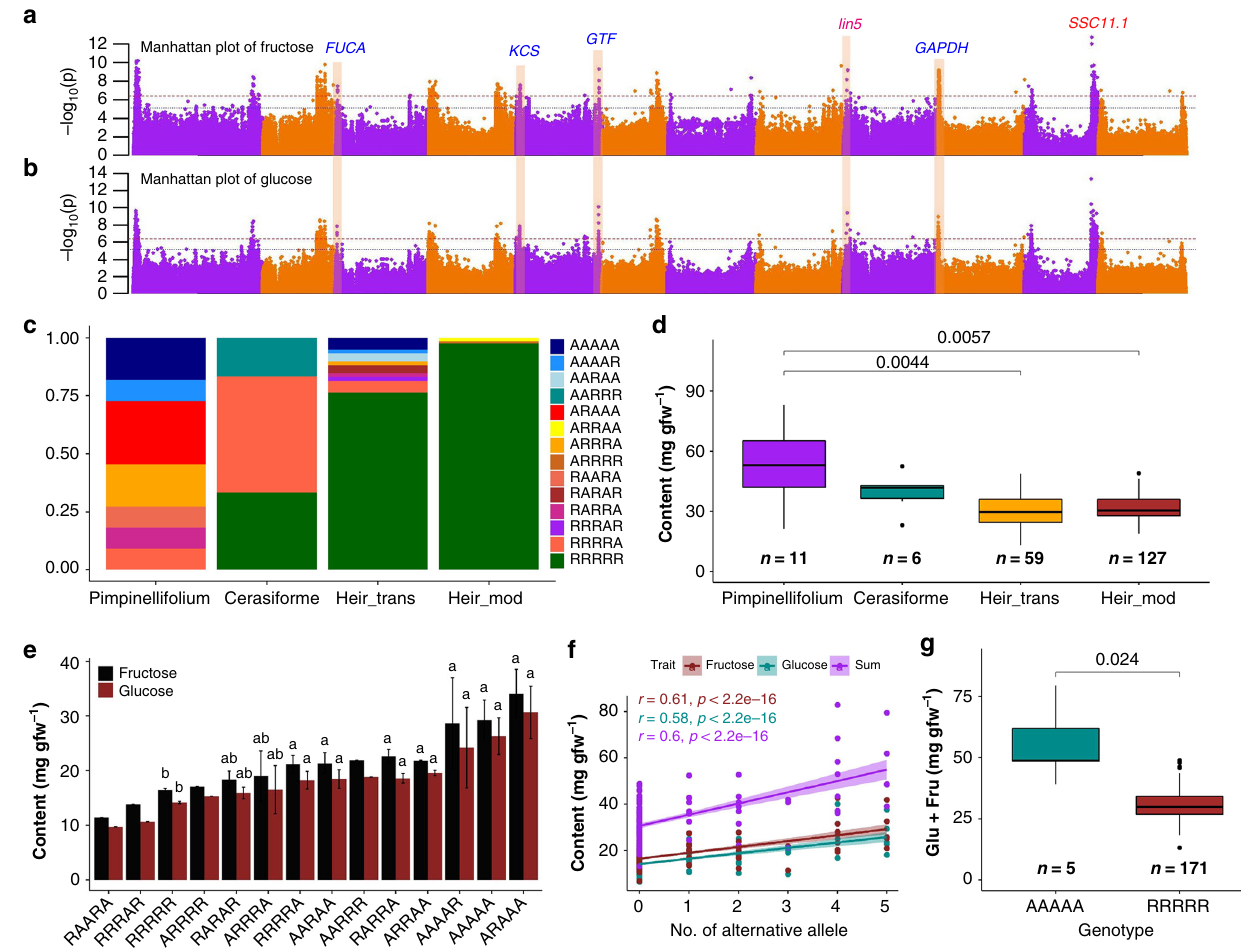
Fig. 2 Combinations of fructose and glucose alleles for the improvement of tomato sugar content. Only alleles that were signi fi cantly associated both with fructose and glucose were analyzed. a , b Manhattan plot for meta-analysis of genome-wide association analysis of fructose ( a ) and glucose ( b ) content. Candidates and previously identi fi ed genes were labeled in blue and red, respectively. FUCA, alpha-L-fucosidase 1 ; KCS, fatty acid elongase 3-ketoacyl-CoA synthase ; GTF, glucosyltransferase ; GADPH, glyceraldehyde-3-phosphate dehydrogenase . c Allele distribution of fructose/glucose content at positions: chr3:1,506,106, chr5:3,403,706, chr5:63,485,334, chr9:3,477,979, and chr10:422,707 that were both signi fi cantly associated with fructose and glucose in S. lycopersicum var cerasiforme (cerasiforme), heirloom + transitional (heir_trans), heir + modern (heir_mod), and the closest wild species S. pimpinellifolium (pimpinellifolium) tomato accessions (see detailed information about groups in online methods). d Comparison of sugar content (fructose + glucose) between different tomato types in cerasiforme, heir_trans, heir_mod, and pimpinellifolium tomato accessions. e Mean (±SE) content of fructose (black) and glucose (brown) at different allele combinations in cerasiforme, heir_trans, heir_mod, and pimpinellifolium tomato accessions. Signi fi cant t -test P values are also provided. f Correlation between the number of alternative alleles and sugar content. Fructose, glucose, and the sum of fructose + glucose were colored in brown4, cyan4, and purple. g Comparison of sugar content (fructose + glucose) between all alternative and reference allele combinations at position chr3: 1,506,106, chr5: 3,403,706, chr5: 63,485,334, chr9: 3,477,979, and chr10: 422,707. Center line and limits of box were the mean and interquartile ranges. Error bars represent the maximum and minimum values. Whiskers indicate variability outside the upper and lower quartiles. Signi fi cant t -test P values are also provided. Source data of Fig. 2c – g are provided in a Source Data fi